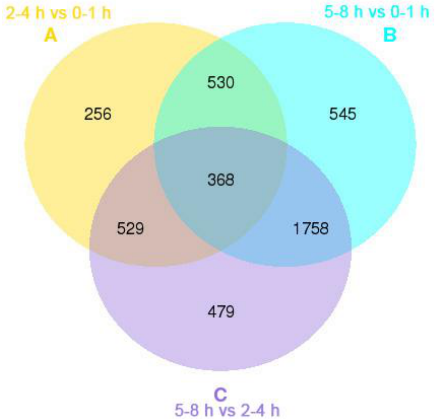
Figure 3. Venn diagram representing the distribution of differentially expressed unigenes in the 0–1, 2–4 and 5–8 h libraries of B. dorsalis early embryos. A, B and C represent the number of differentially expressed unigenes between 2–4 and 0–1 h, between 5–8 and 0–1 h, and between 5–8 and 2–4 h libraries, respectively.